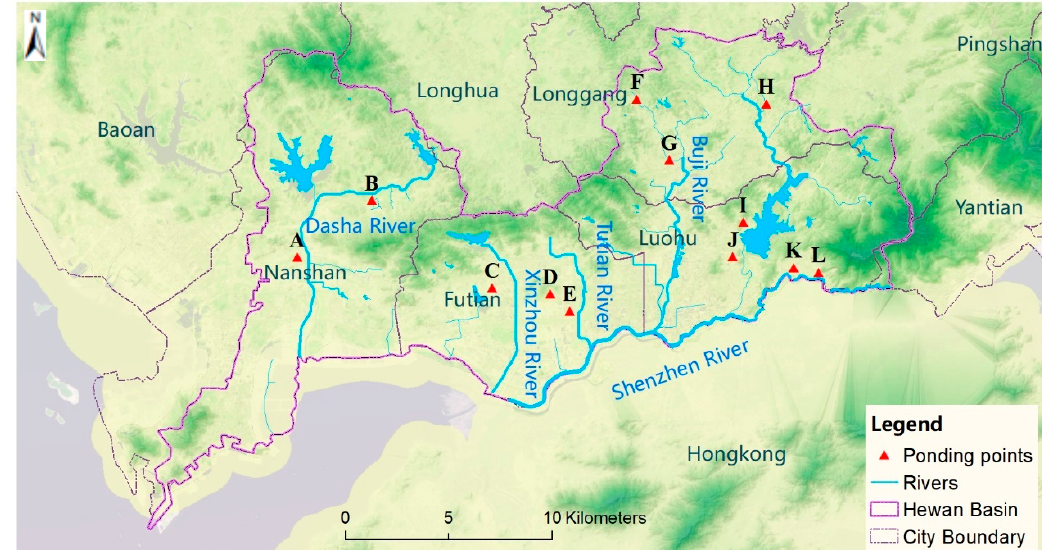
Figure 8. Distribution of ponding points. (Number of A–L for waterlogging point). Table 1. Comparison of maximum ponding depths of measured values and simulated results at waterlogging points during a heavy rainstorm in Shenzhen on 29 August